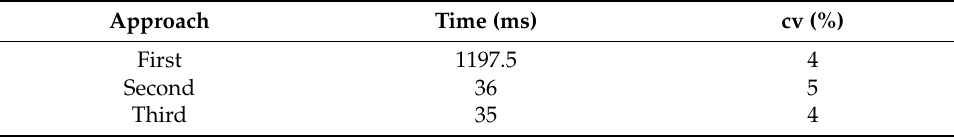
Table 9. State recreation, execution time r = 2.